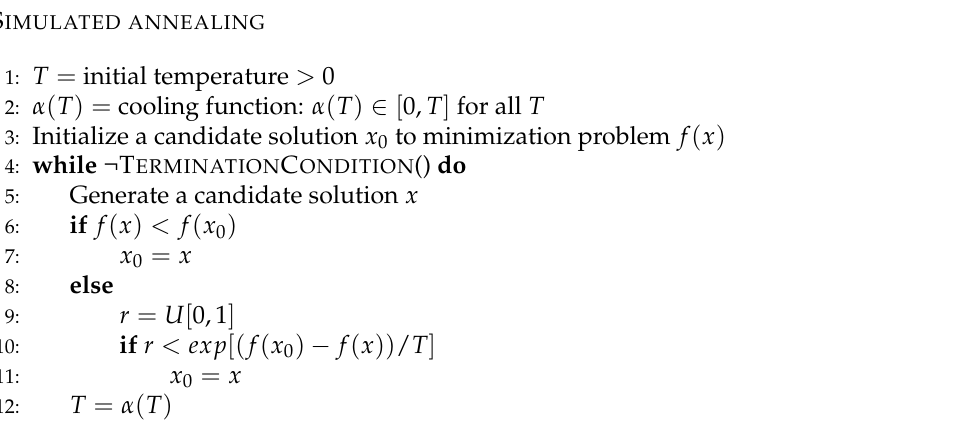
Algorithm 9 Simulated Annealing [25]